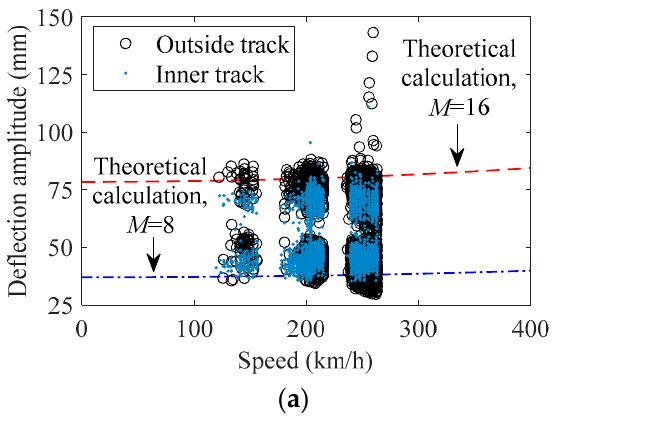
Figure 8. Amplitude of train-induced response versus train speed at Section G validated by theoretical calculation: ( a ) deflection; ( b ) acceleration.